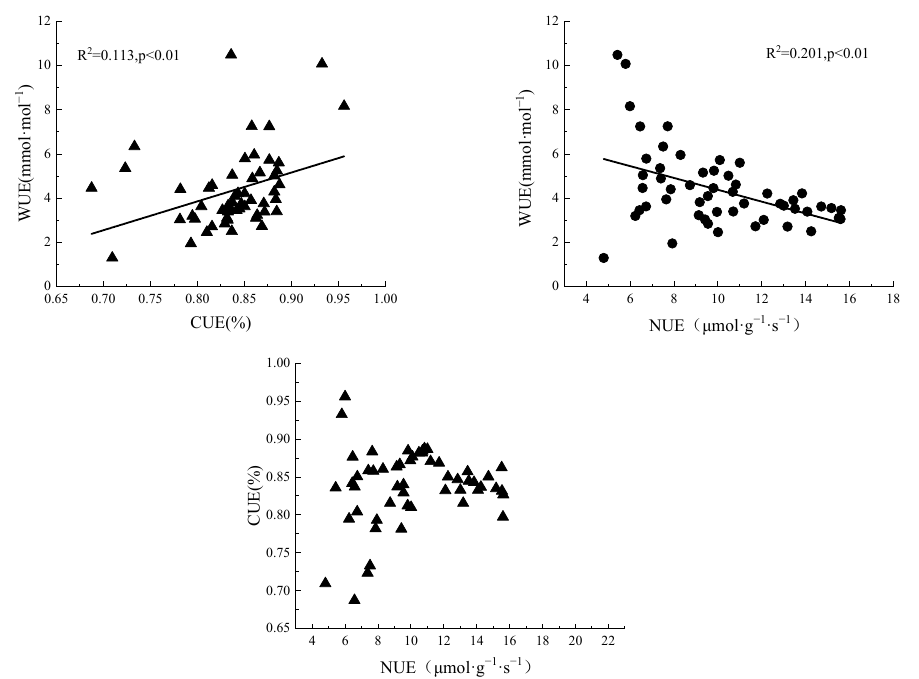
Figure 4. Relationship between resource utilization efficiencies.